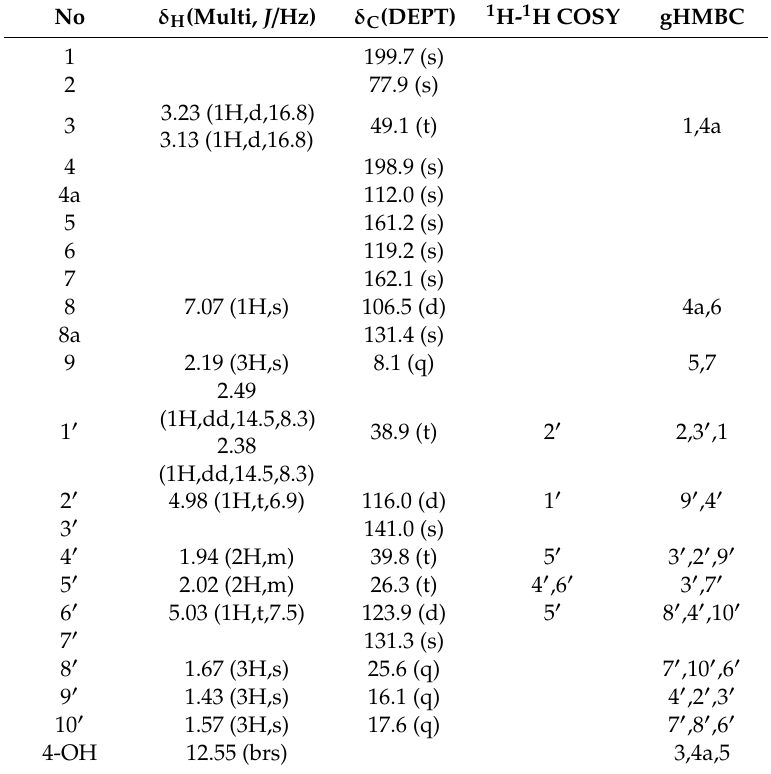
Table 3. 1 H and 13 C-NMR, 1 H- 1 H COSY, gHMBC data of 3 (600 MHz, CDCl 3